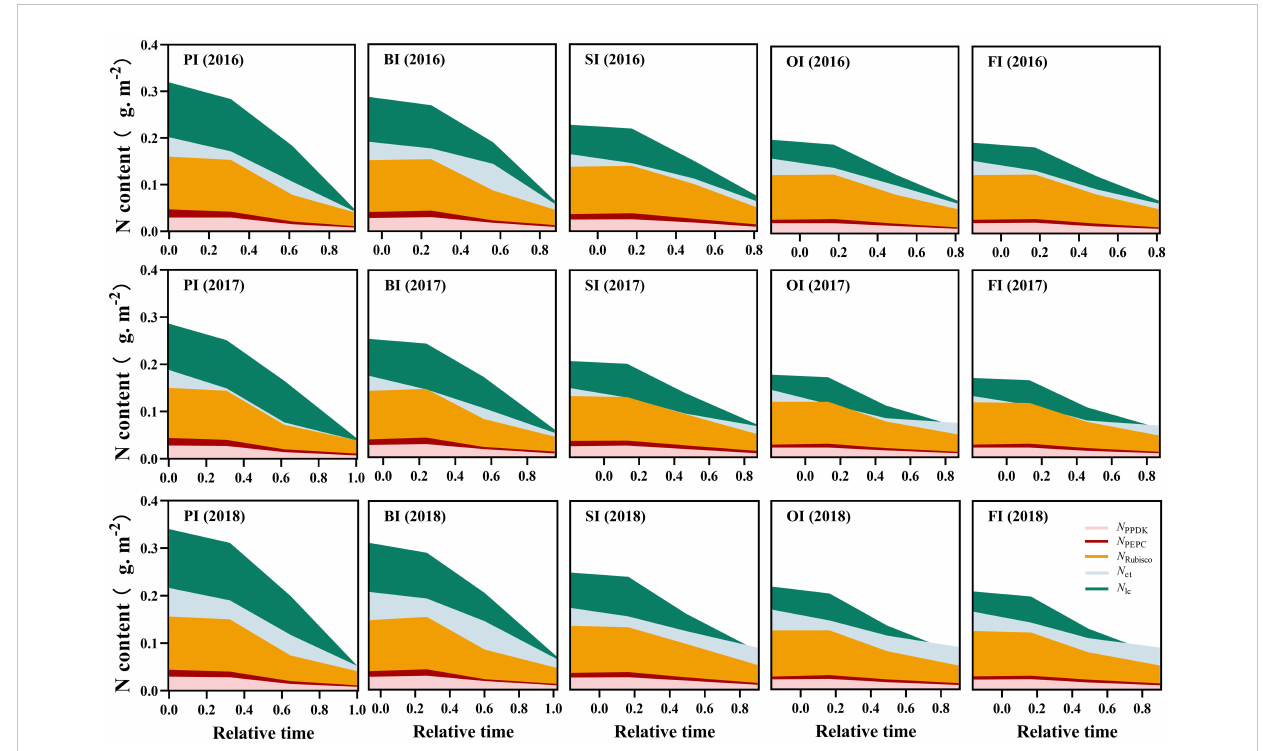
FIGURE 3 Leaf photosynthetic N dynamics during the reproductive period. PI and BI represent drip irrigation under plastic fi lm mulch and biodegradable fi lm mulch, respectively; SI, drip irrigation incorporating straw returning; OI, drip irrigation with the tape buried to a shallow soil depth; FI, furrow irrigation. Relative time is the ratio of days after silking to the duration from silking to maturity. N PPDK , N PECP , and N Rubisco represent N content in PPDK, PEPC, and Rubisco protein, respectively. N lh , protein N responsible for light harvesting system. N et , protein N responsible for electron transport/ bioenergetics. The data in this fi gure are presented in Table S4 for further